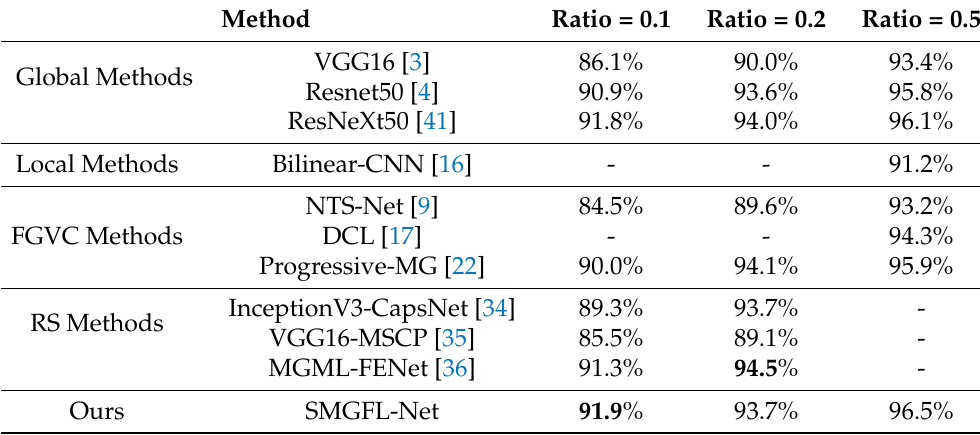
Table 5. Comparative results on